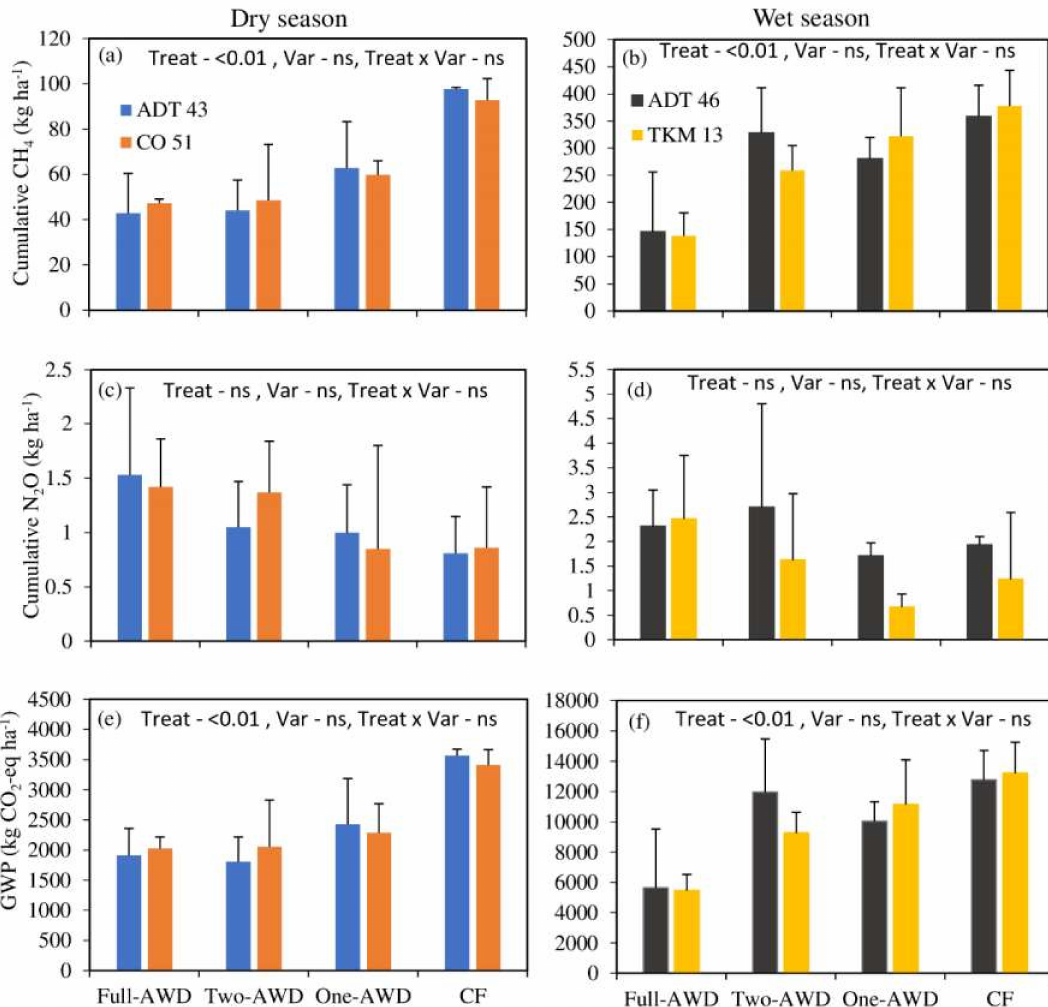
Figure 5. Cumulative CH 4 ( a , b ) and N 2 O ( c , d ) emissions from rice paddies and their contribution in the global warming potentials ( e , f ) as affected by different water management practices. Error bars indicate standard error of means ( n = 3). The y axes scales are different. Arrow—start AWD irrigation. Full-AWD—wetting and drying cycles throughout the growing season, Two-AWD—two early drying periods, One-AWD—one early drying period, CF—continuous